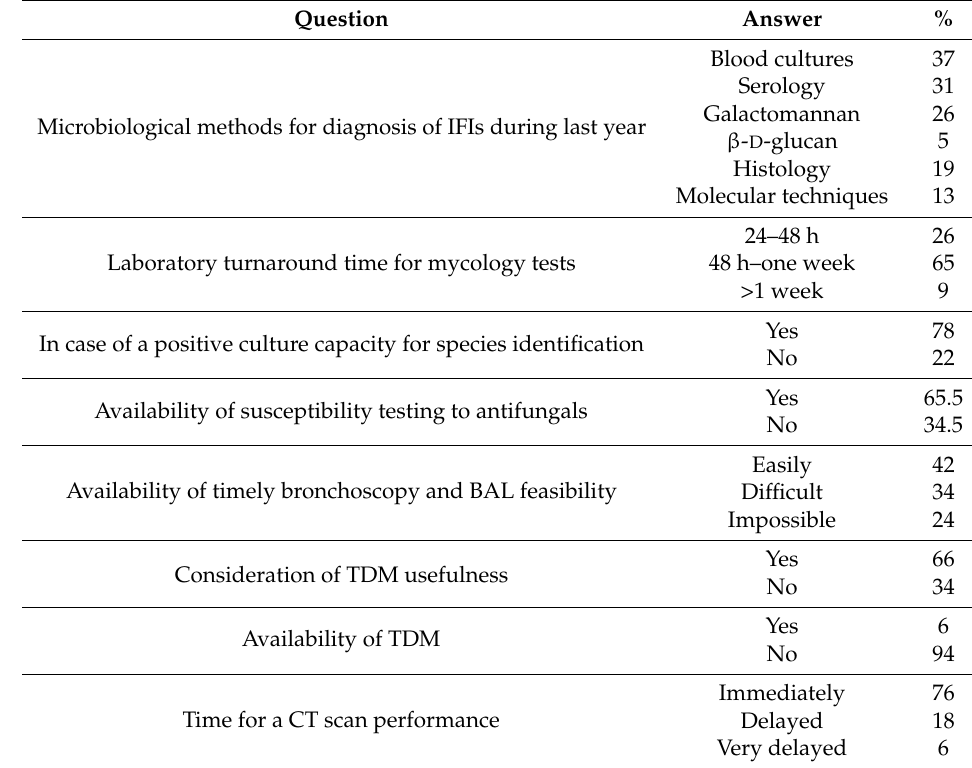
Consideration of TDM usefulness